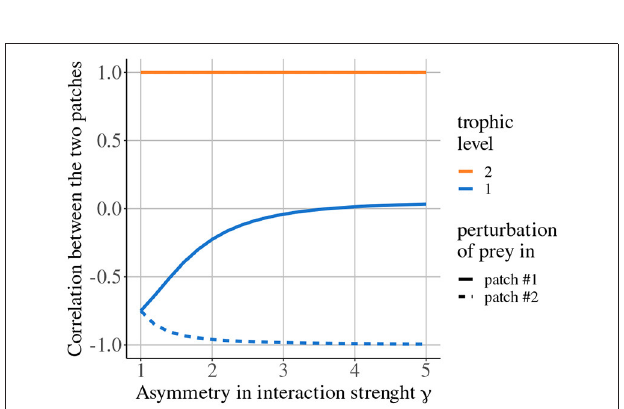
FIGURE 7 | Correlation between the two populations of prey and predators depending on asymmetry of interaction strength γ when prey are perturbed in either patch #1 or patch #2. Only predators are able to disperse ( ε a ma γ ). Adapted from Quévreux et al. (in 10, d 2 10 3 and ω = = =